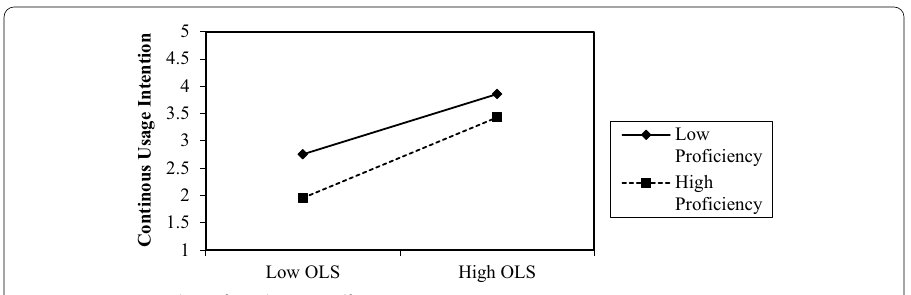
Fig. 3 Interaction plots of moderating